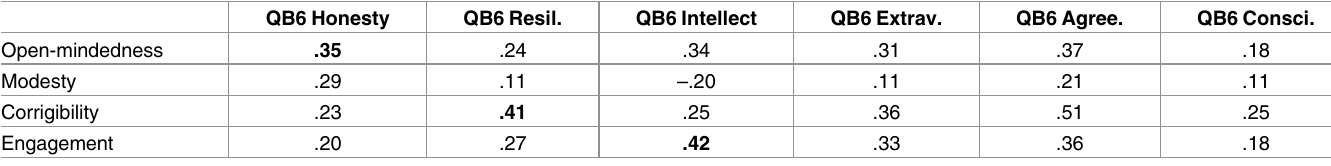
Table 10. Correlations between IH scalesand Big Six